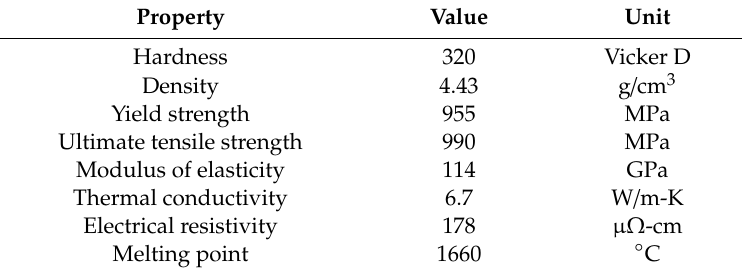
Table 2. Salient properties of workpiece.